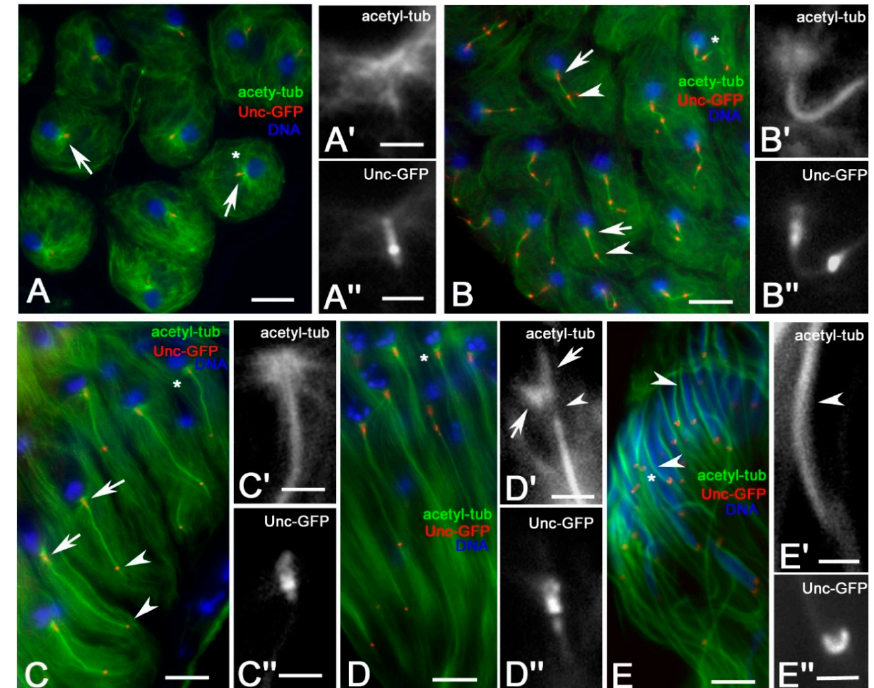
Figure 3. Distribution of acetylated MTs during spermatid elongation from dissected testes. ( A ) Young round spermatids in which centrioles and cilium-like regions are evident (arrows): detail of the small aster of MTs ( A’ ) in correspondence of the centriole ( A” ). ( B , C ) Elongating spermatids in which the Unc-GFP staining recognized the basal body (arrows) and a subdistal dot (arrowheads) corresponding to the ring centriole: ( B’ , C’ ) are details of the proximal region of the axoneme and of the small aster of MTs close to the nucleus, ( B” , C” ) are details of the Unc-GFP localization to the basal body. ( D ) MTs and Unc-GFP labelling in more elongated spermatids: the small aster is no longer visible, but the MTs surround the basal region of the nucleus (arrows). Note the gap between perinuclear and axoneme MTs (arrowhead, D’ ), where the basal body is localized ( D” ). Most of the perinuclear MTs run at one side of the canoe stage nuclei (arrowheads, E , E’ ), whereas the Unc-GFP transforms in a compact cluster (E” ). High magnification images to right details are from spermatids marked by asterisks. Scale bars: ( A – D ), 10 µ m; ( A’ – D’ , A” – D” ), 1 µ